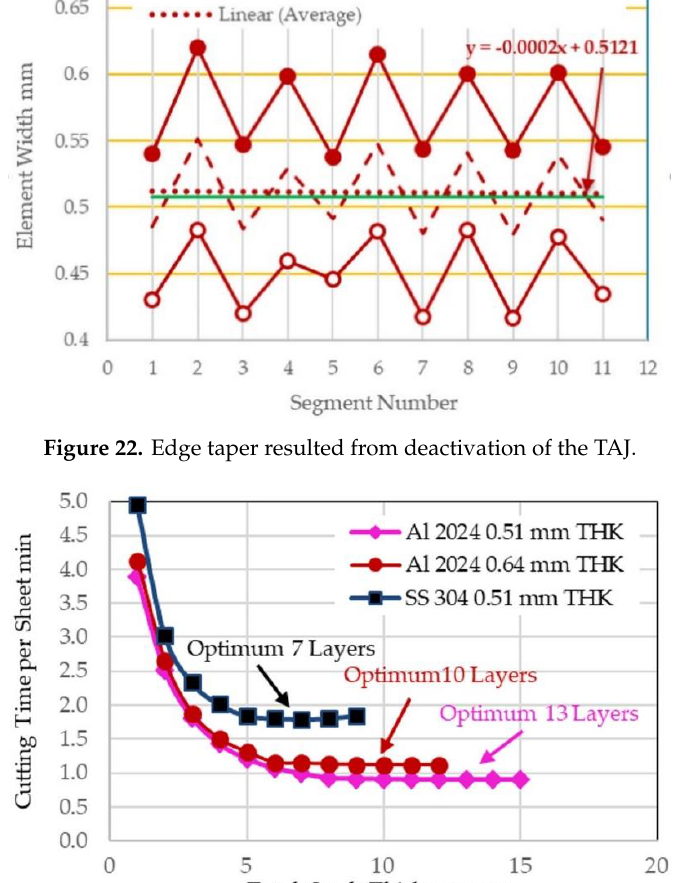
Figure 24. AWJ-cut stack of stainless-steel flexure supported by aramid honeycomb.